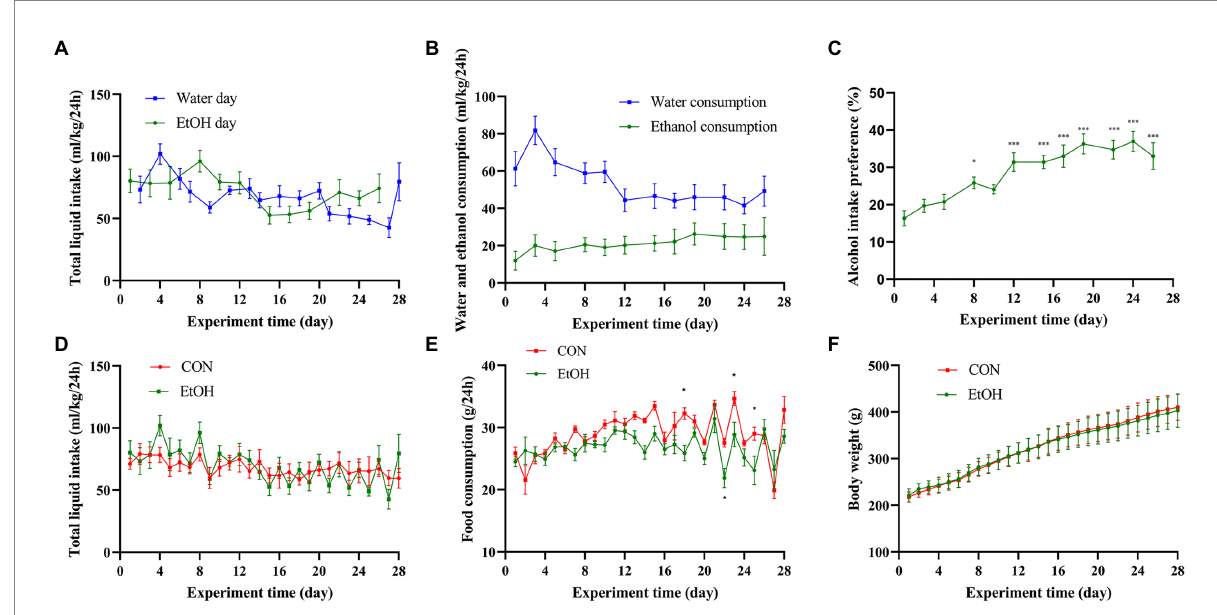
FIGURE 2 IA2BC affected alcohol intake preference but did not affect body weight or liquid/food intake. (A) The total liquid intake showed no significant difference between the water day and EtOH day in EtOH group. (B) The ethanol consumption was increasing with the water consumption was decreasing in IA2BC rats. (C) Alcohol intake preference was increasing with chronic intermittent ethanol voluntary drinking time. The total liquid intake (D) , food consumption (E) or body weight (F) did not altered by chronic intermittent ethanol voluntary drinking. Data are presented as Mean ± SEM, n = 8/group; compared with the first day, * p < 0.05, ** p < 0.01, *** p <